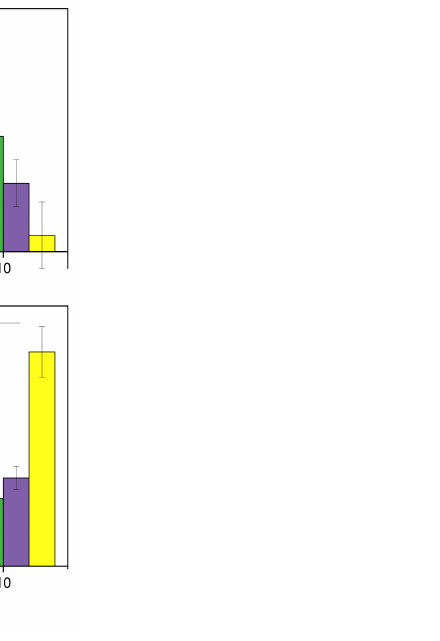
Figure 10. Comparison of living and dead cells per mm 2 for the geometry variations, n = 30; with p < 0.05